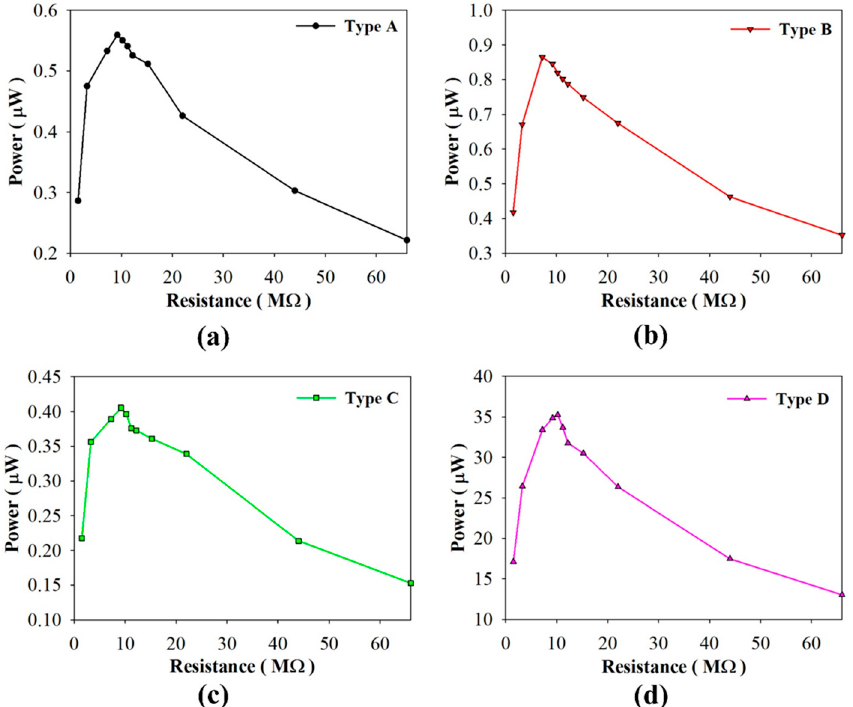
Figure 12. Harvested power as functions of the load resistance when using the PZT cells of various structures and the period of 4 s. ( a ) Type A; ( b ) Type B; ( c ) Type C; ( d ) Type D.